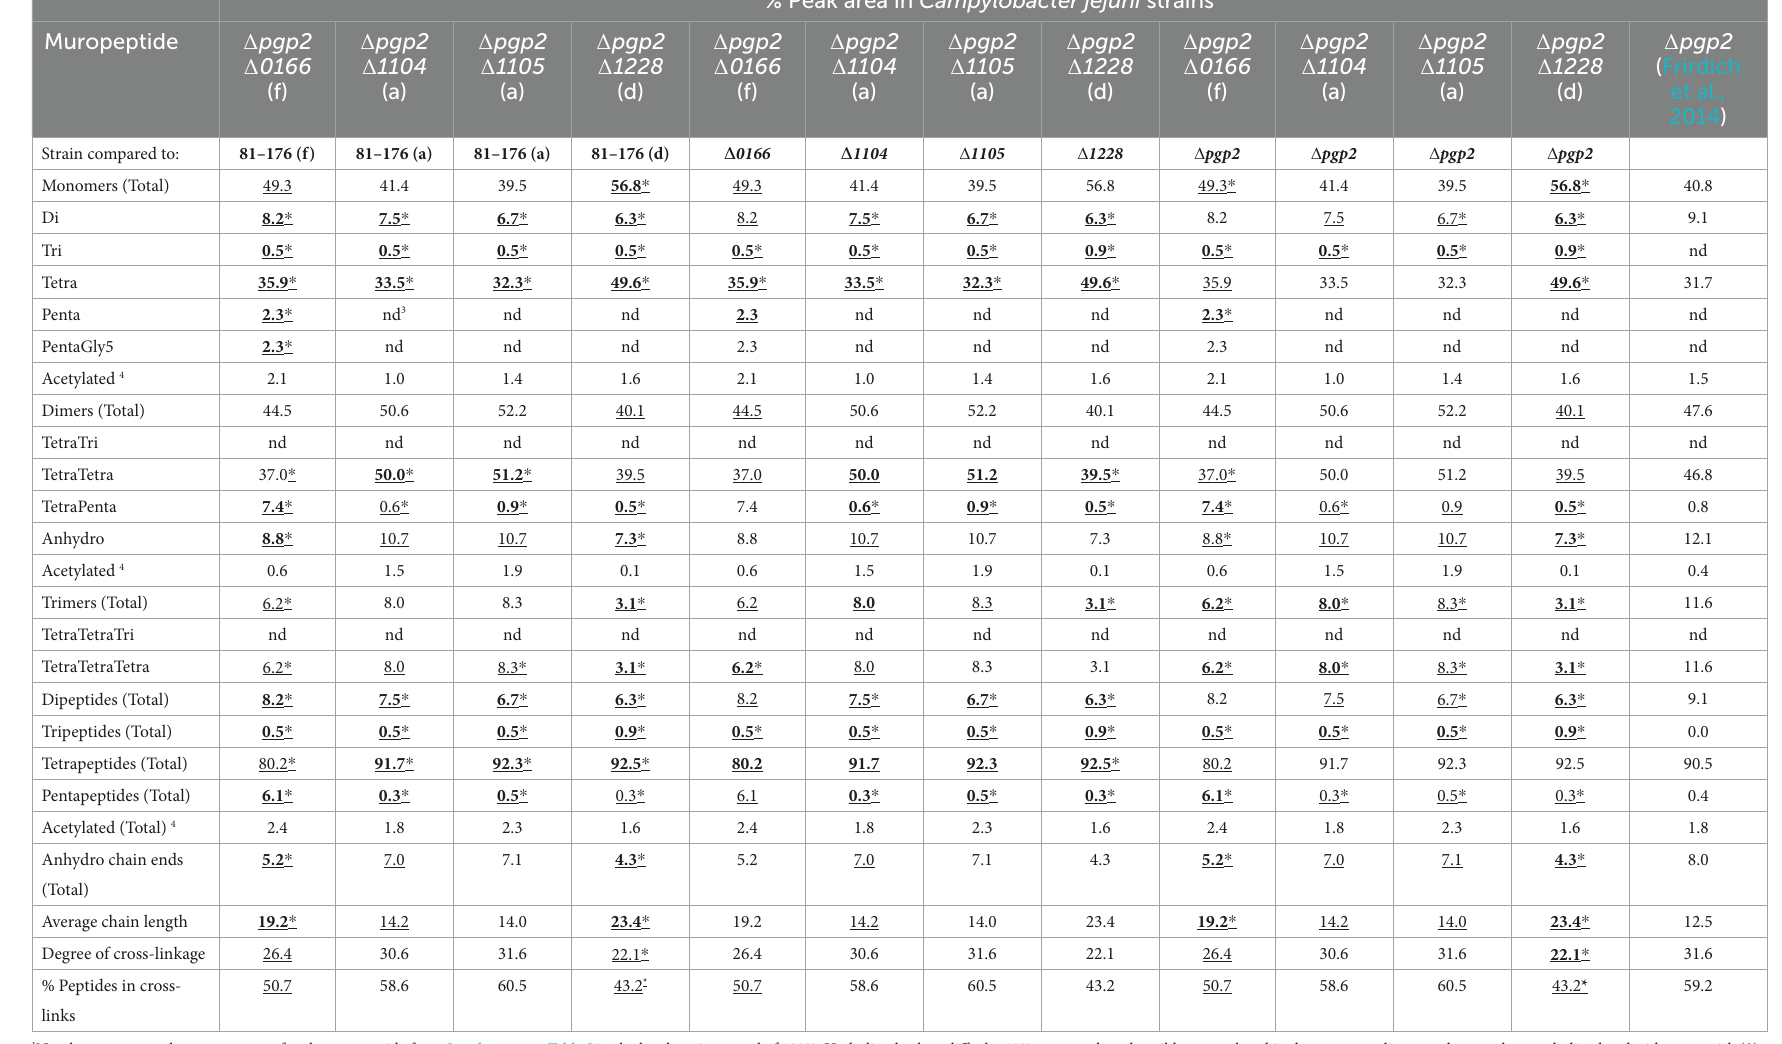
TABLE 4 Summary of the muropeptide composition of double mutants with pgp2 and 0166 , 1104 , 1105 , or 1228 .